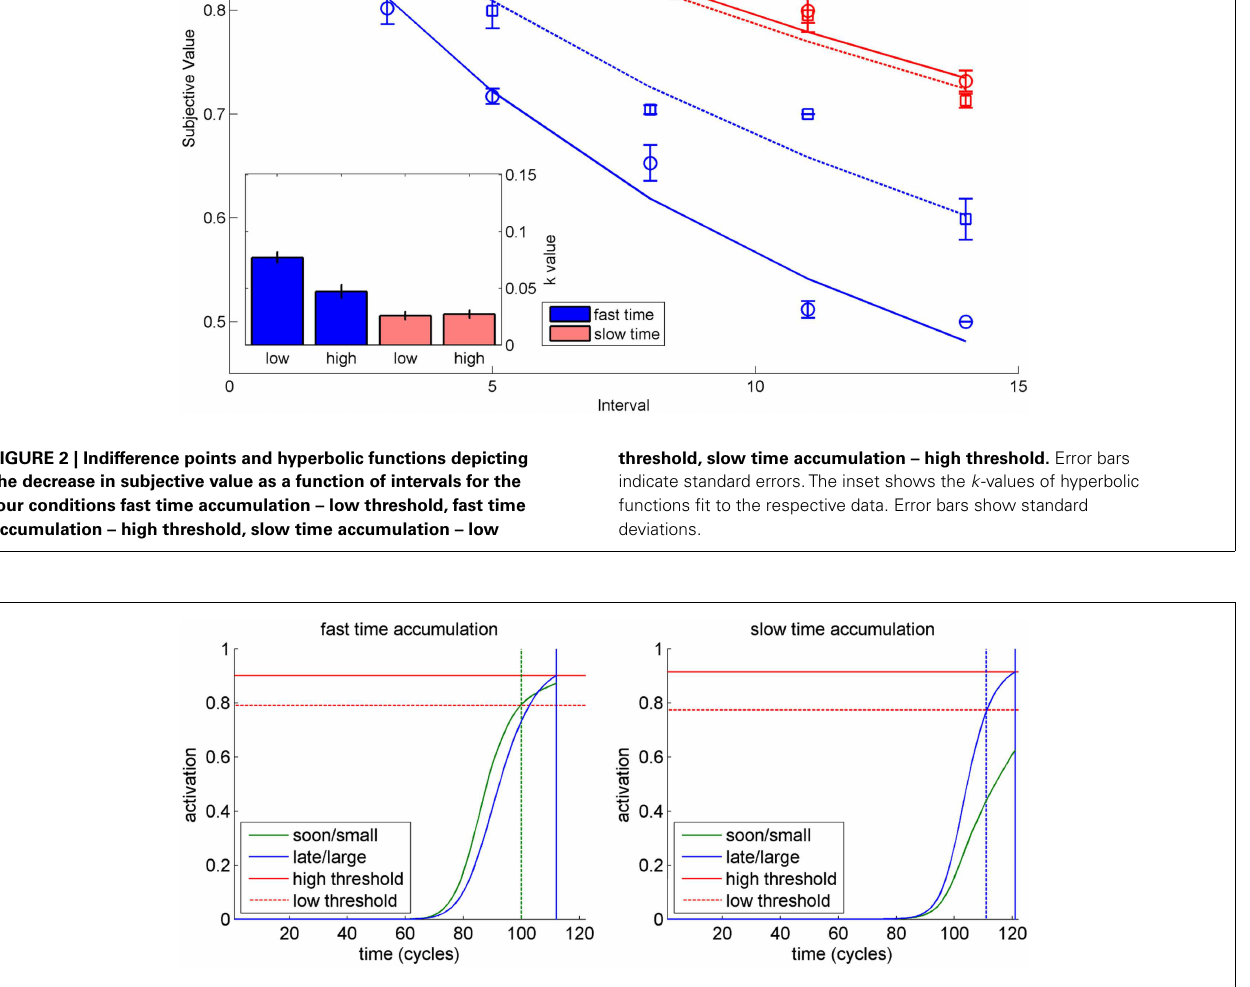
FIGURE 3 |Activation dynamics of the units in the response layer in a representative trial of one simulated participant in the different simulated conditions. In the fast time accumulation condition (left), the activation of the sooner/smaller response dominates in beginning of a